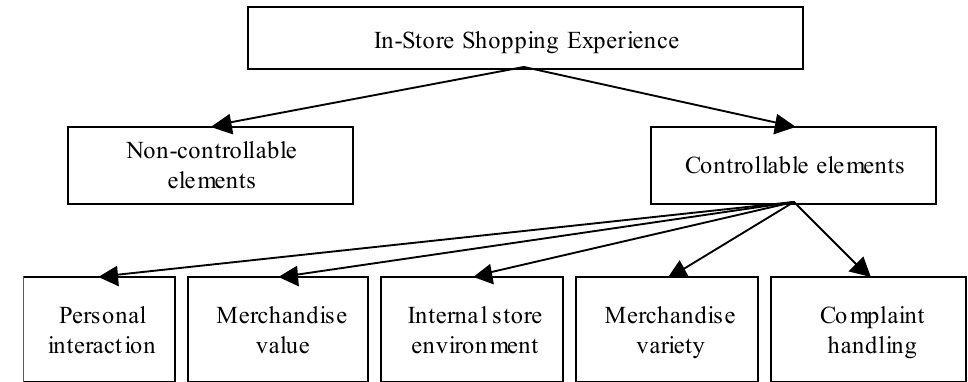
Figure 3: Empirical results of survey 2 The methodology of the third